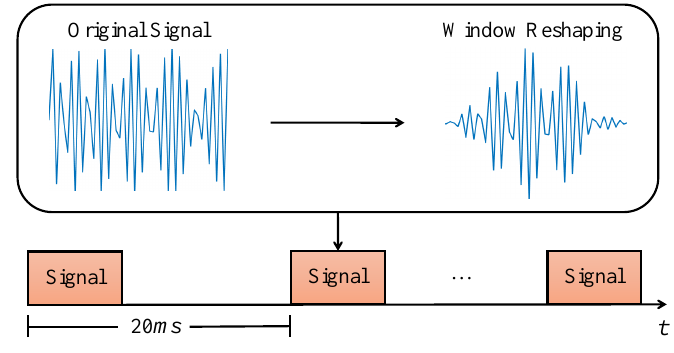
Figure 4. Hand geometry transmitter